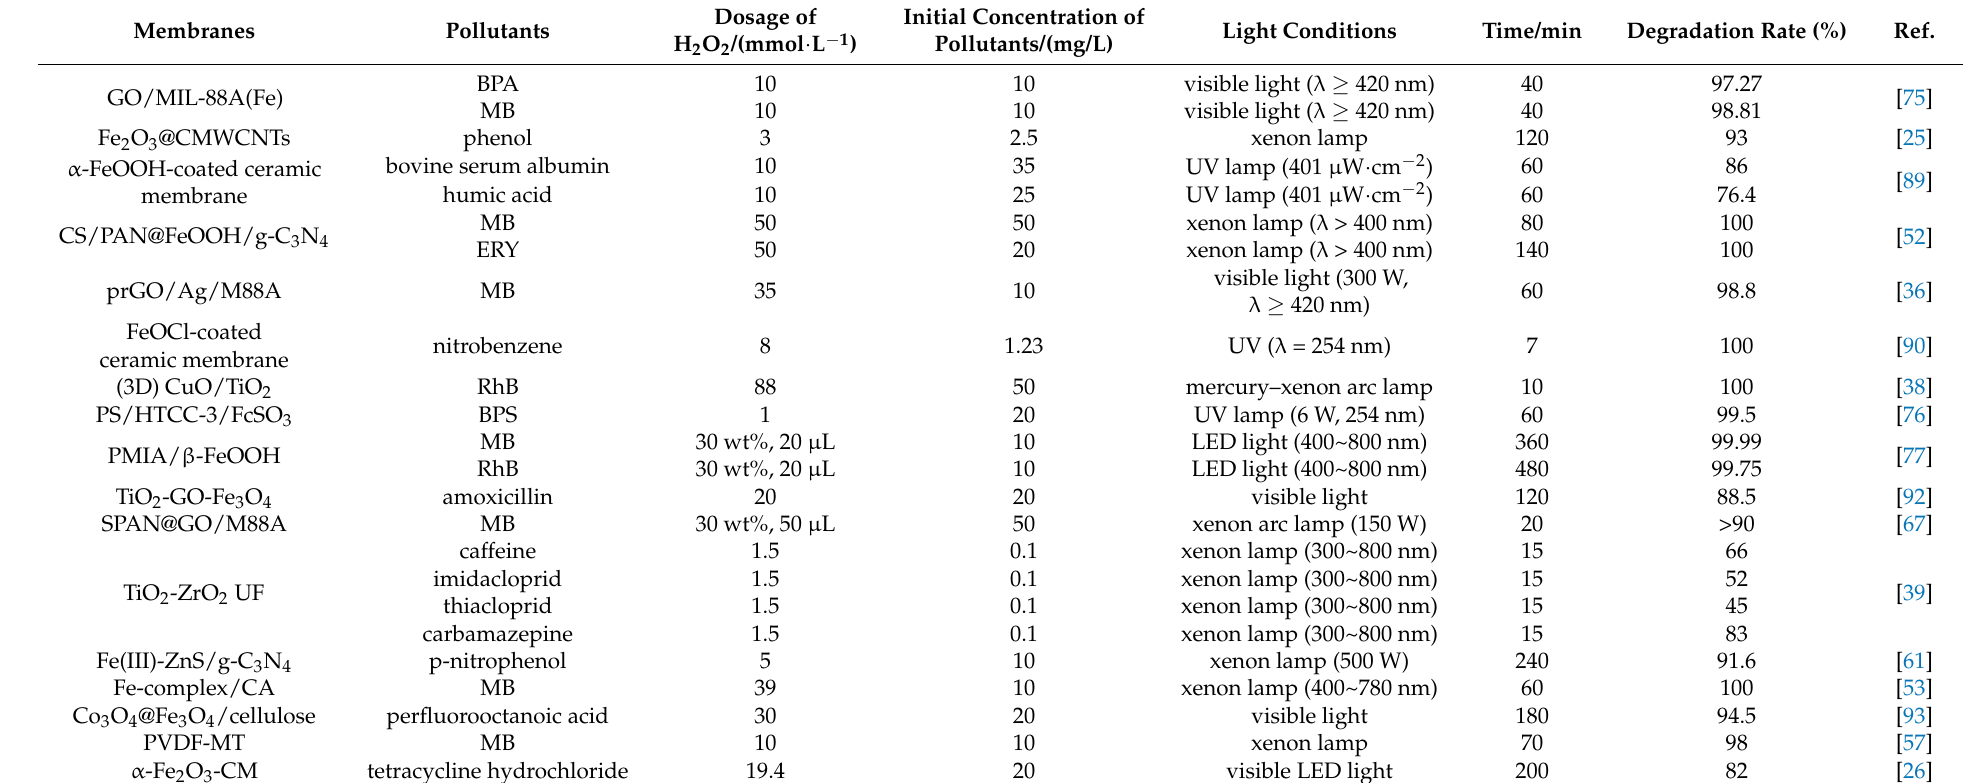
Table 2. Degradation performance and experimental conditions of different photo-Fenton